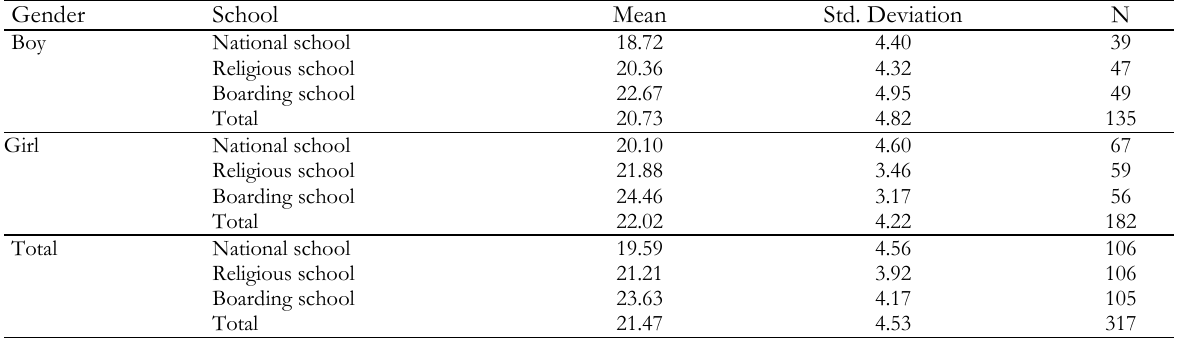
Table 3. Levene's Test of Equality of Error Variances F *The mean difference is significant at 0.01 level Table 4. Tests of between-gender and types of schools effect Types III Sum of Source Corrected Model